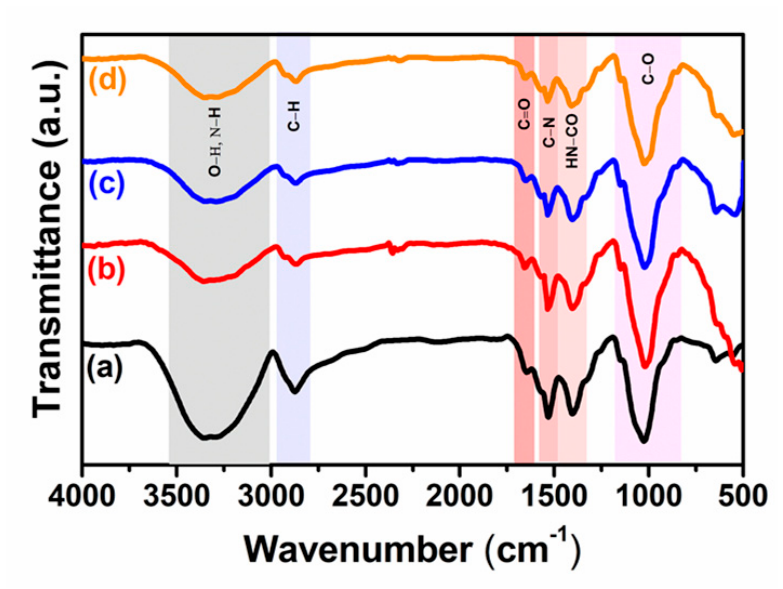
Figure 1. The ATR/FTIR analyses of ( a ) pCS, ( b ) pCS-0.4PBLO, ( c ) pCS-1PBLO, and ( d ) pCS ‐ 1.2PBLO.